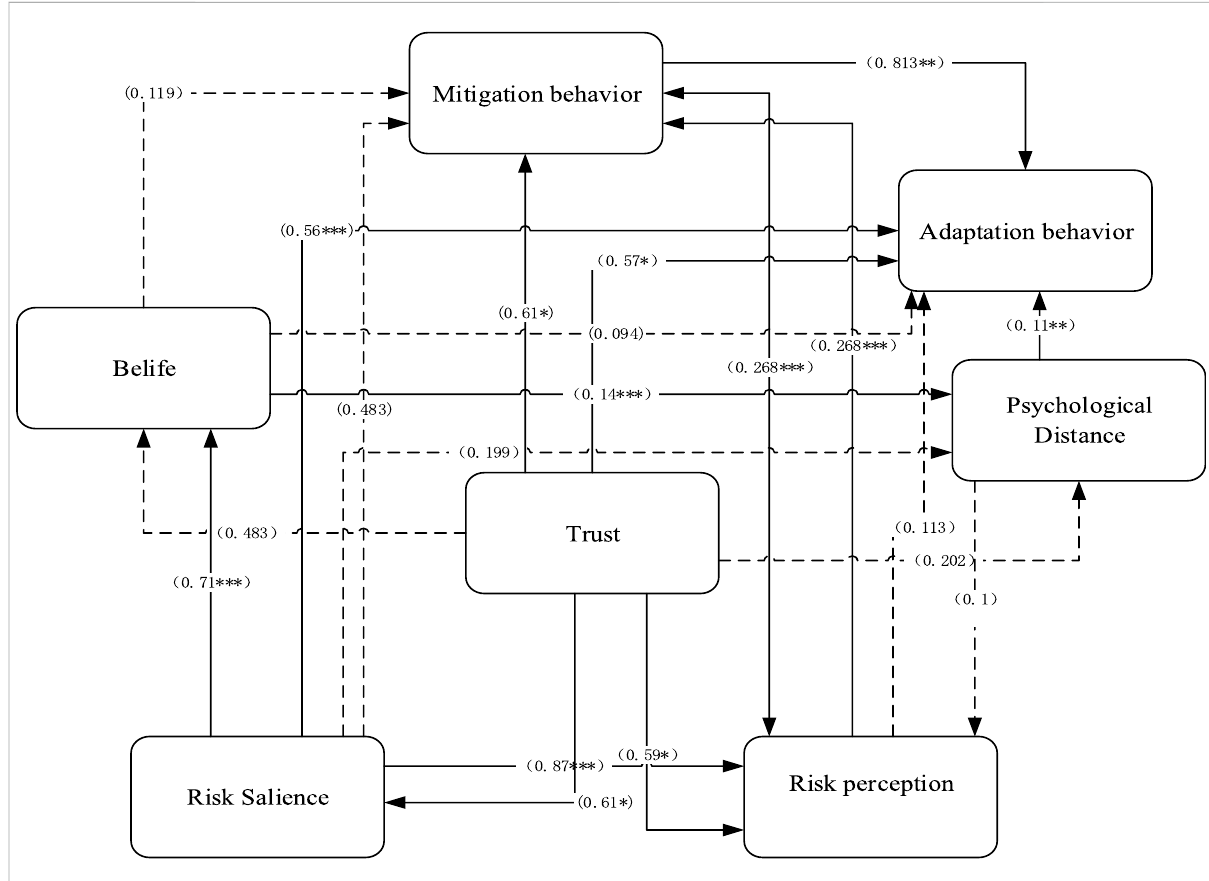
FIGURE 2 Structural equations modeling and path coef fi cients between variables in Henan. Note: non-signi fi cant (*** p < 0.001, ** p < 0.05, * p < 0.1).